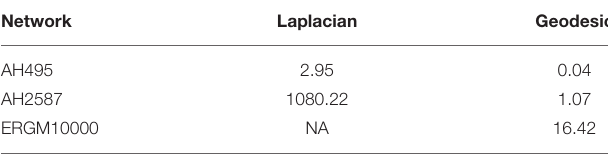
TABLE 1 | Computational time in seconds to run Algorithms 1, 2 .